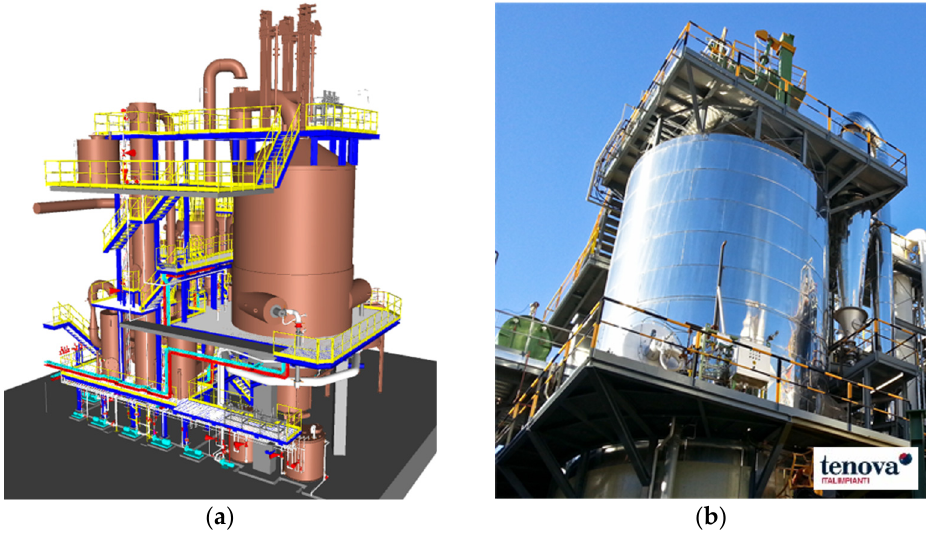
Figure 4. The Tenova MgO roaster, with a capacity of 3000 L/h of MgCl 2 solution: ( a ) 3D model developed during the design phase; ( b ) the completed unit in operation.